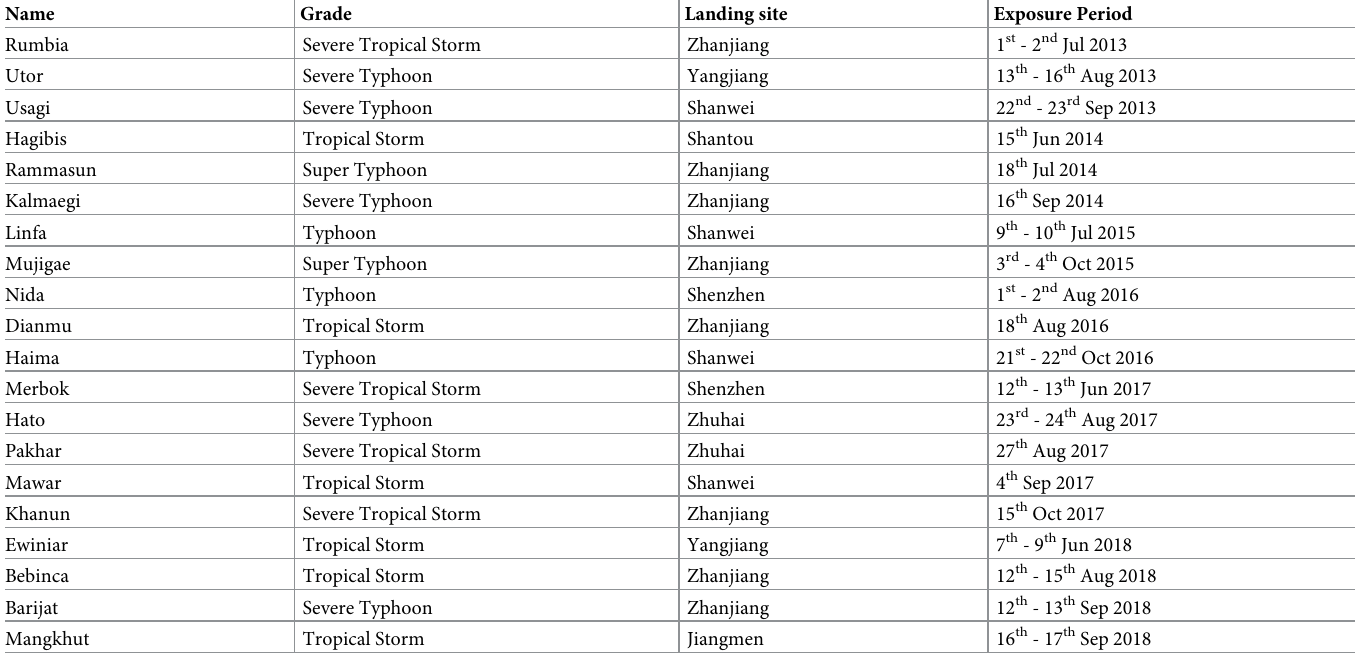
Table 1. Basic information of tropical cyclones affecting the PRD from 2013–2018.